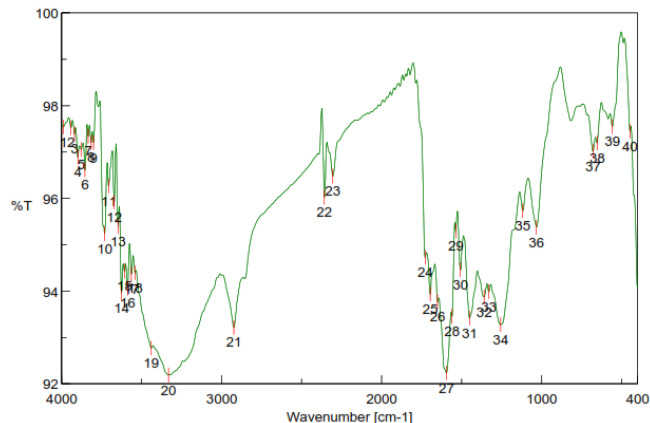
Fig. 2: FTIR spectrum of bamboo activated carbon after adsorption